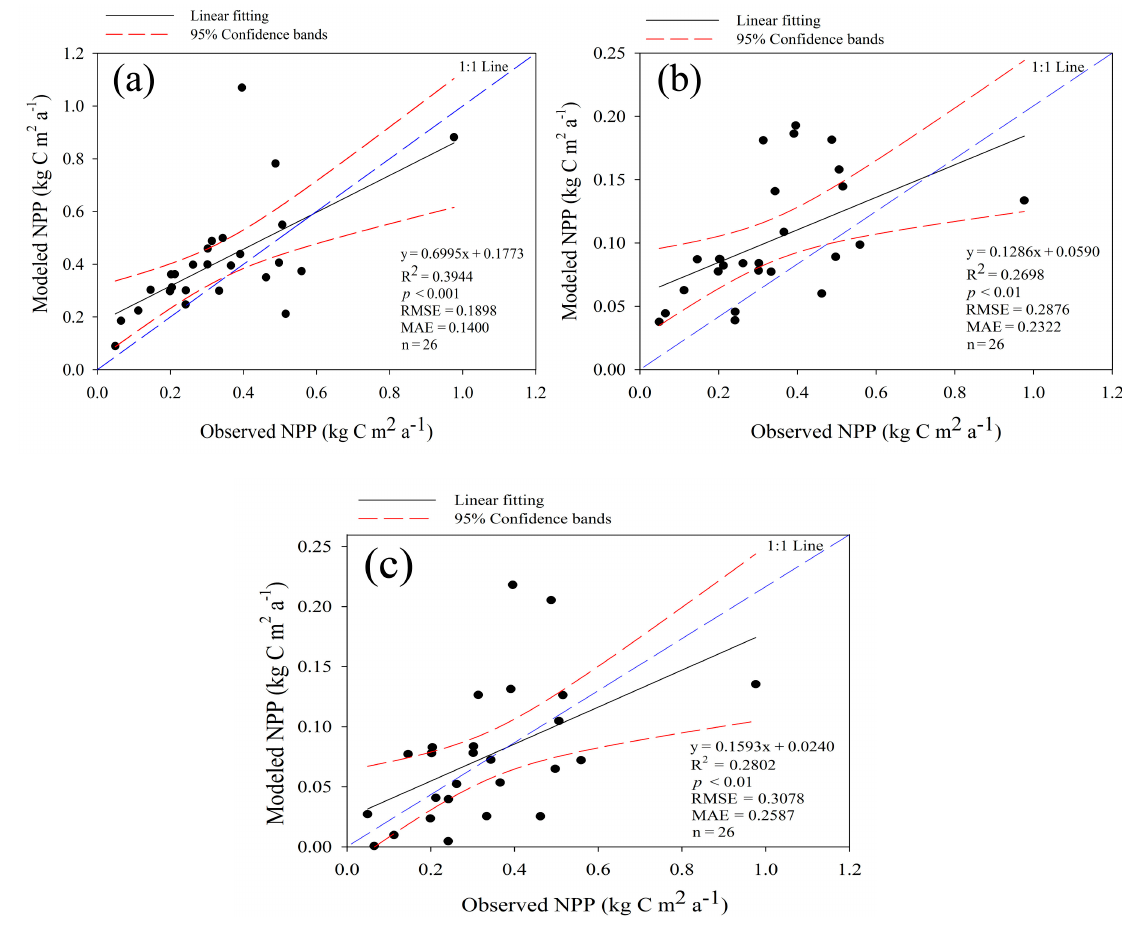
Figure 1. Comparison between the in situ Net Primary Productivity (NPP) site observations and NPP derived from MODIS ( a ); Miami model ( b ); and Thornthwaite Memorial model ( c ).